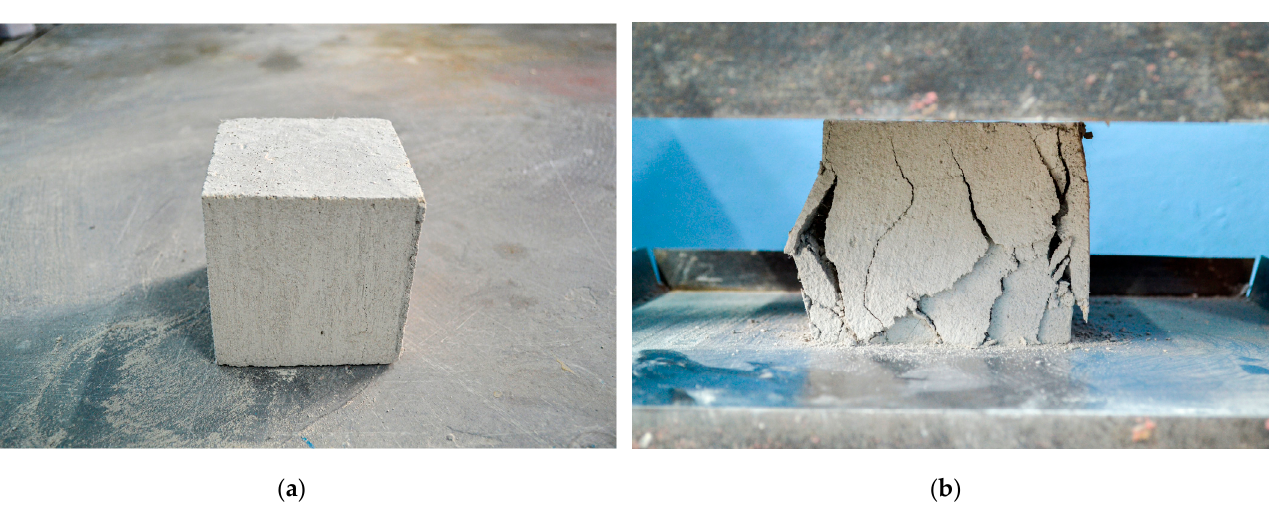
Figure 5. Sample of aerated concrete modified with GGBS and reinforced with SF: ( a ) before the compression test; and ( b ) after the compression test.